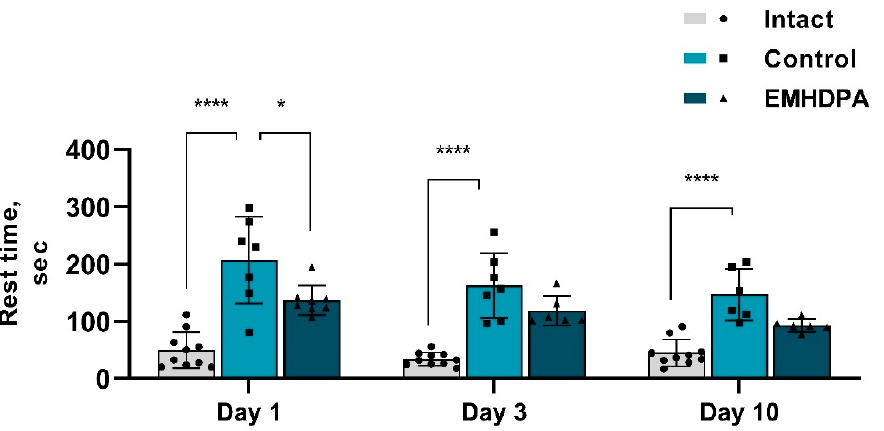
Figure 9. The effect of the studied drugs on the rest time in the actimetry test. Note: *— p < 0.05; ****— p < 0.0001; 1—intact group; 2—control group; 3—group administered with EMHDPA 25 mg/kg.